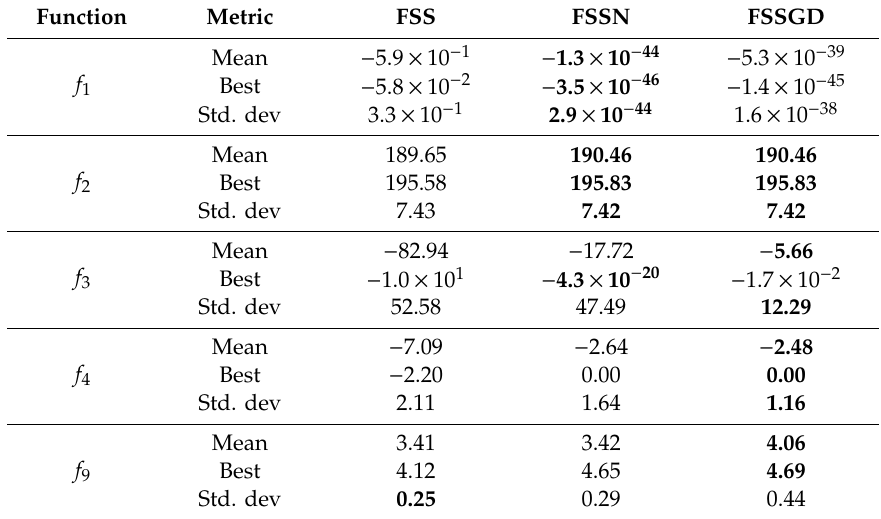
Table 2. Accuracy comparison of the algorithms optimizing 5-dimensional functions from Table 1.